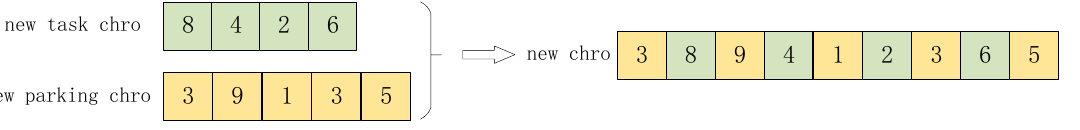
Figure 10. Paired combination of the chromosomes after the mutation operation.